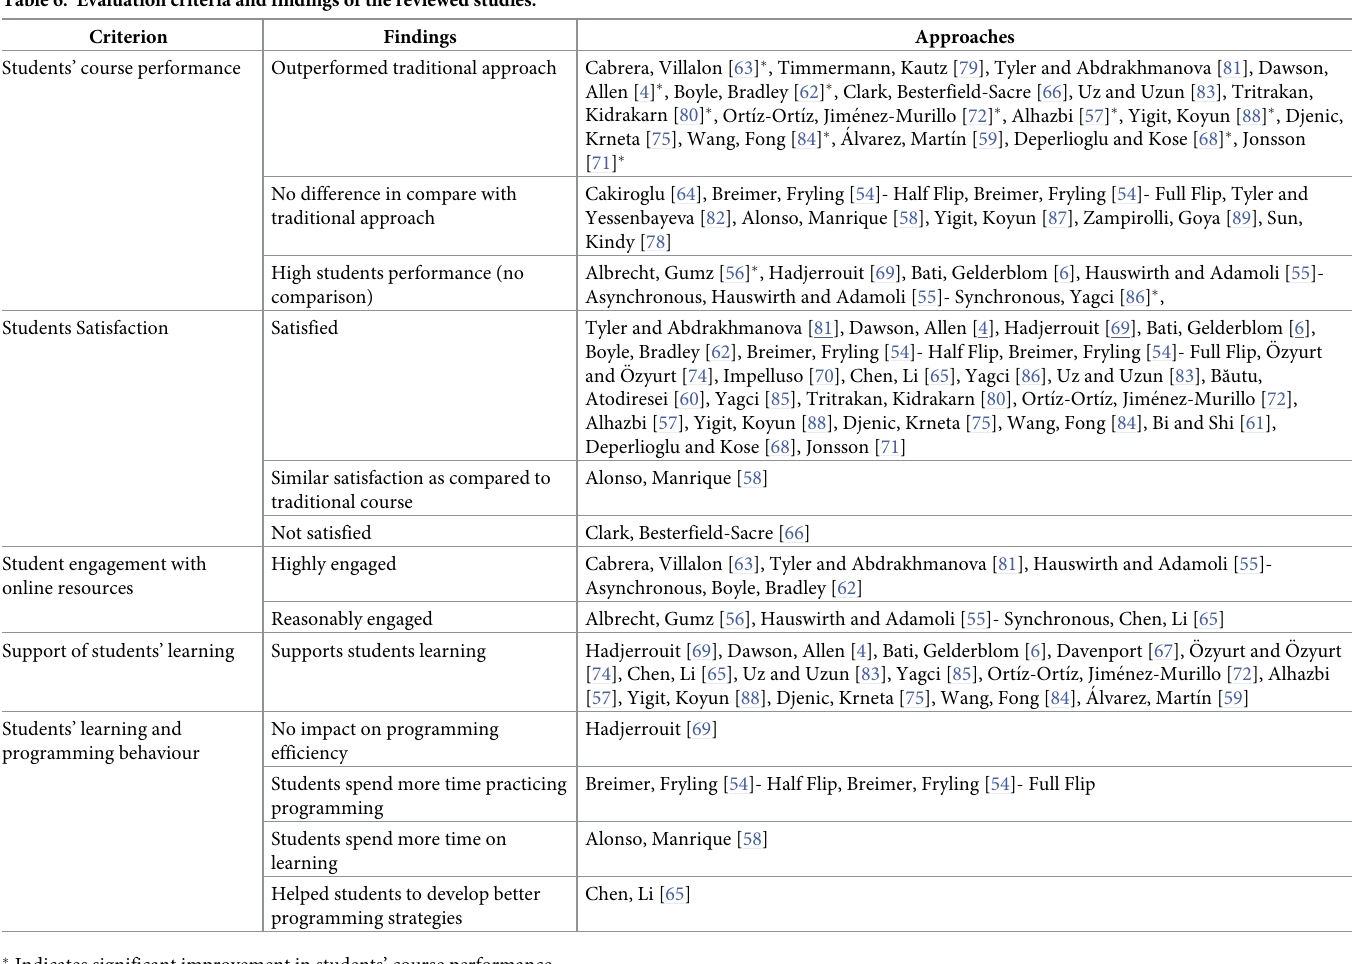
Table 6. Evaluation criteria and findings of the reviewed studies.